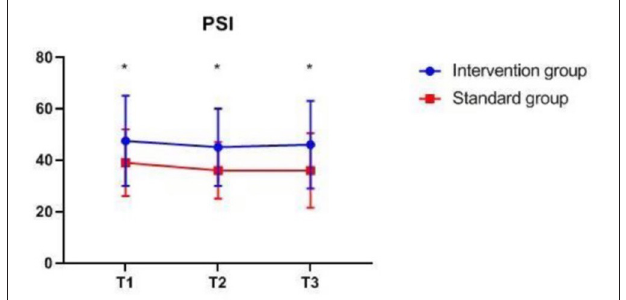
FIGURE 6 | Ipsilateral MFV MAC over time. MFV MAC , mean flow velocity of middle cerebral artery. The measurement time interval after general anesthesia but before clamping the carotid artery was recorded as baseline reference T1, the time interval after clamping but before declamping was recorded as T2, and the time interval after the declamping and stabilization of cerebral perfusion but before completion of surgery was recorded as T3. MFV MAC , bilateral mean flow velocity of middle cerebral artery.